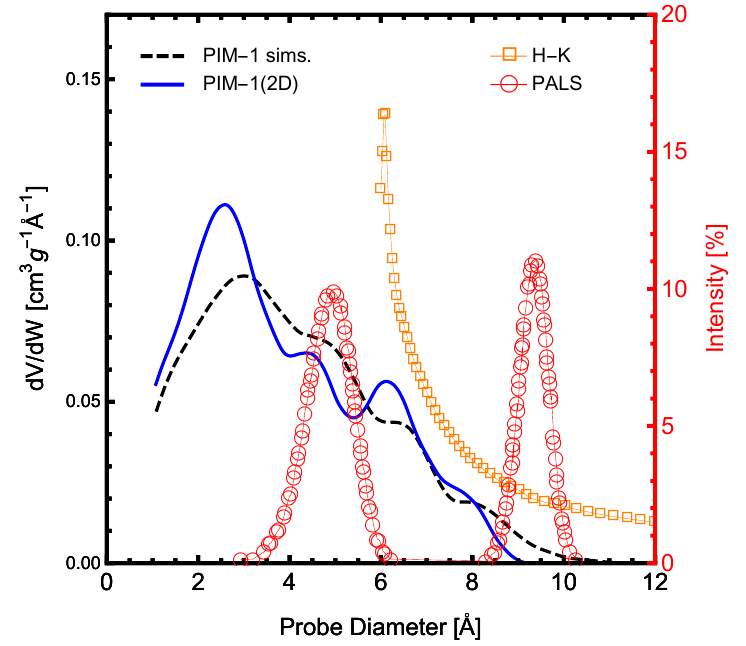
Figure 3. The pore size distribution of the two-dimensional PIM-1 sample used here (PIM-1 (2D)), in a solid blue line, compared with the molecular simulations of [26] (dashed black line). Also shown are available pore size distributions of experimental PIM-1 samples using positron annihilation lifetime spectroscopy (PALS) of PIM-1 in the powder form in red open circles [52] and using the Horvath–Kawazoe (H-K) method applied to N H-K in orange open squares [50]. The PALS data are reported in percent intensity according to the right